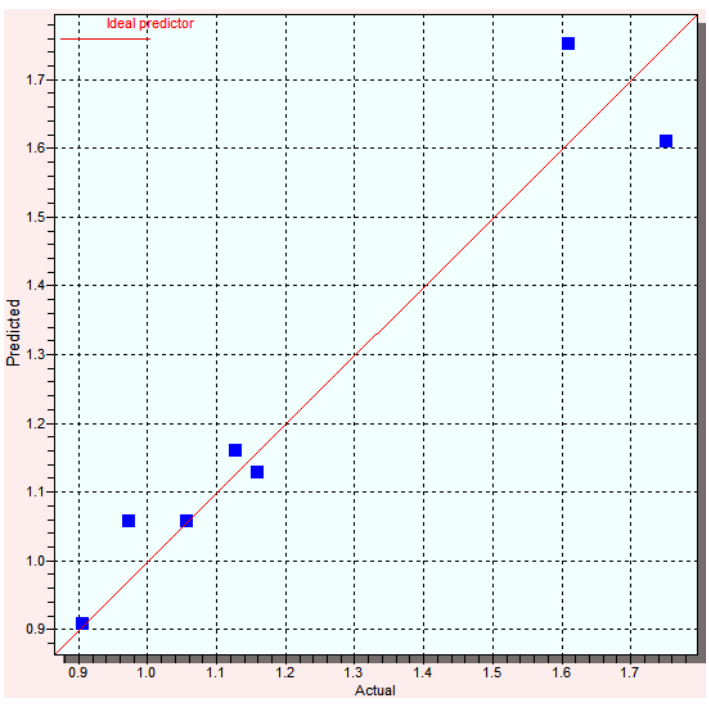
Figure 5. Calculated against experimental antiradical activity.